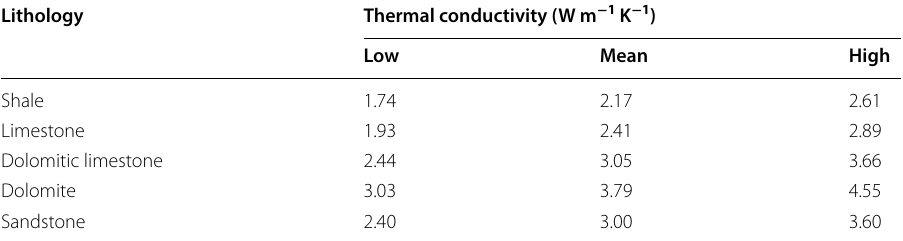
Table 1 Theoretical thermal conductivity for each lithology with mean values from